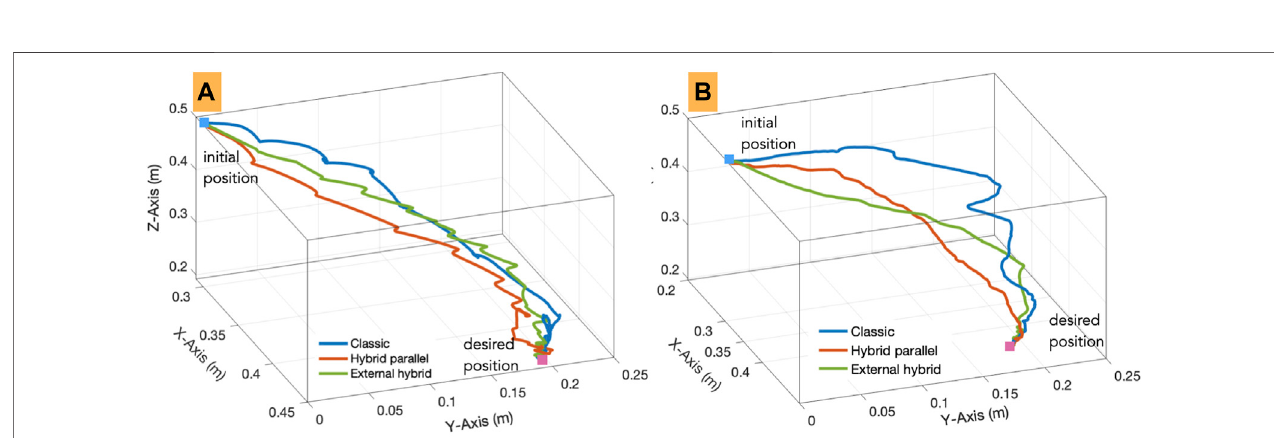
Frontiers in Robotics and AI |